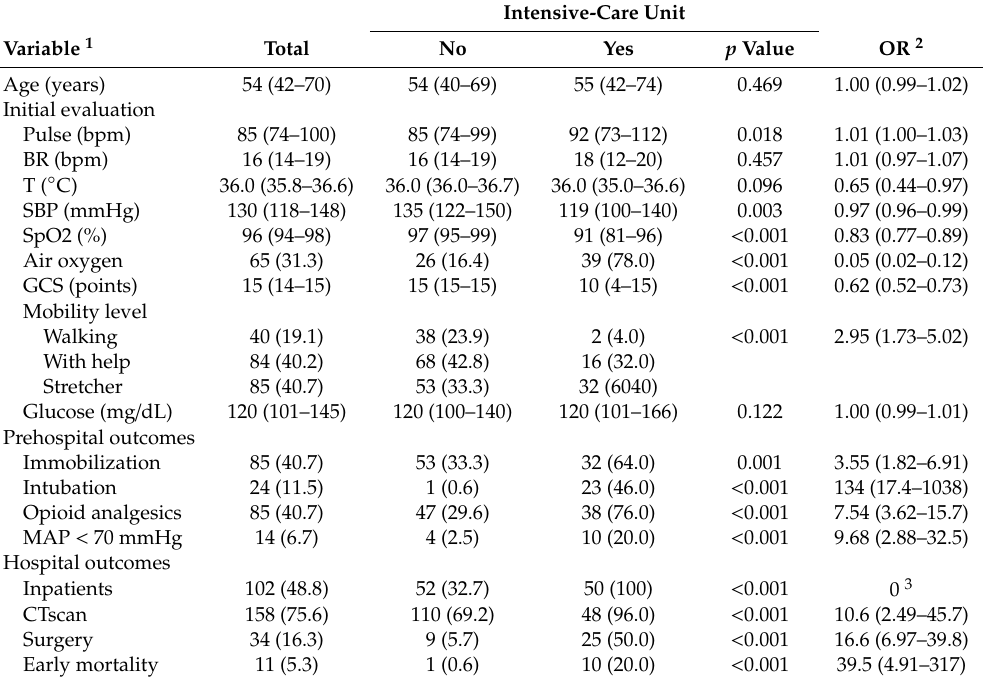
Table 2. Outcomes of study subjects. Reference rates to intensive-care unit